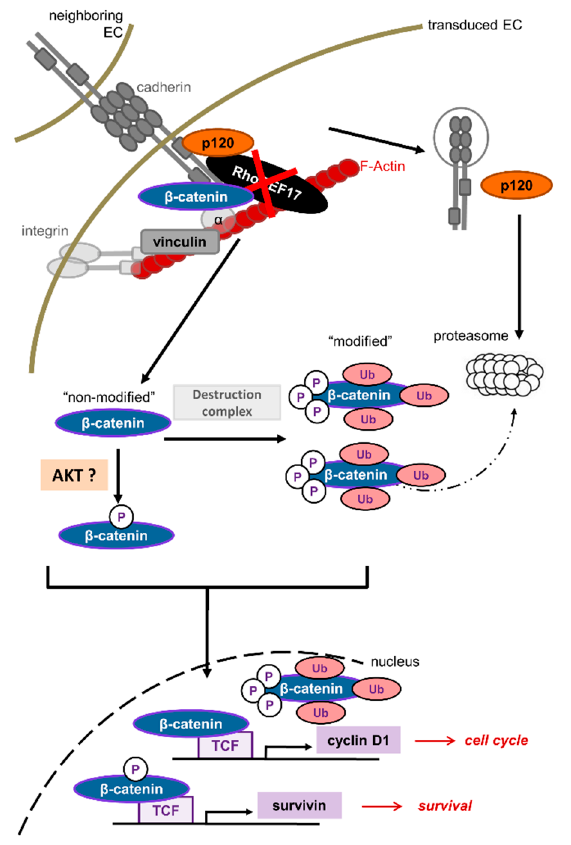
Figure 6. Scheme of RhoGEF17 function in EC. RhoGEF17 stabilizes AJ in EC. Its loss leads to AJ protein degradation via the proteasome and an accumulation of β -catenin in its destruction complex (phosphorylated and ubiquitinated) form. A part of the β -catenin pool, which might be phosphorylated by Akt, is translocated to the nucleus and induces β -catenin/TCF dependent gene transcription of, for example, survivin and cyclin D1. Besides impaired cell adhesion and migration due to the disruption of the AJ, RhoGEF17-depleted EC can escape anoikis and end in cell cycle arrest. In contrast neighboring cells, without RhoGEF17 knockdown, enter apoptosis due to the loss of cell–cell contacts. EC = Endothelial cell, RhoGEF17 = Rho-specific guanine nucleotide exchange factor 17, p120 = p120-catenin, α = α -catenin, TCF = Transcription factor, Ub = ubiquitinated, P = phosphorylated. regulation in EC; Figure S2:RhoGEF17 regulates β -catenin; Figure S3: The shp63 adenovirus has no effect on RFPEC adhesion, cell size, and sheet migration; Figure S4: The shp63 adenovirus has no effect on EC apoptosis, caspase 3 expression, and cell cycle.